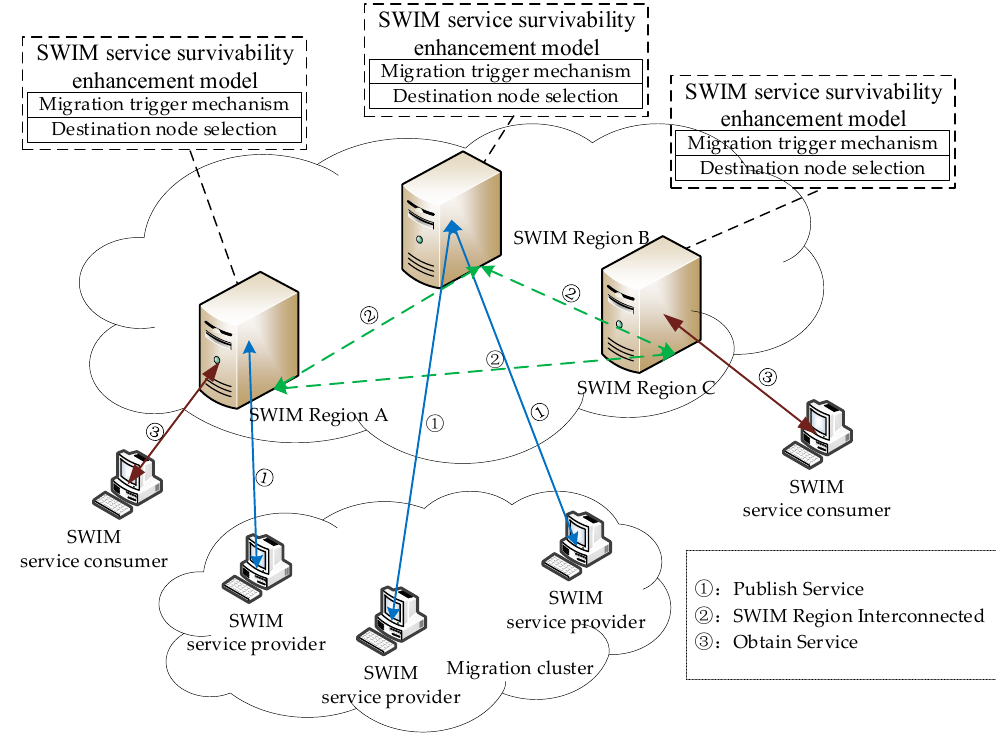
Figure 5. The SWIM service dynamic migration method.